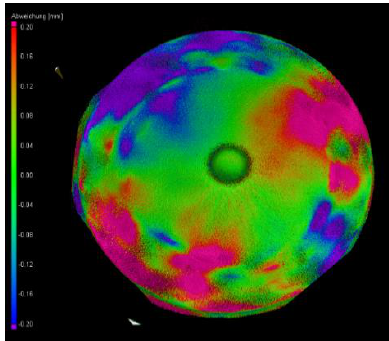
Figure 8. Variance analysis of the 125 kV and 220 kV scans. The colors code the difference in the range of approx. +/- 0.2 mm.